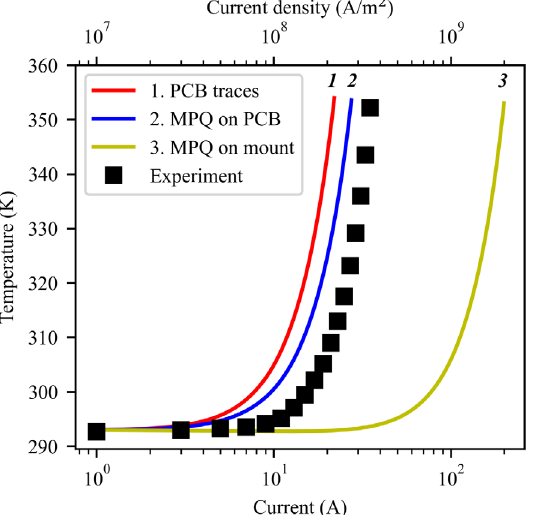
FIG. 7. Steady-state COMSOL thermal simulations at room temperature of devices fabricated in (1) PCB (FR4) material, (2) silicon mounted on PCB, and (3) silicon mounted on a cooled metal mount, compared with the experimental device (similar to device 2). The top x axis is simply a scaled version of the bottom x